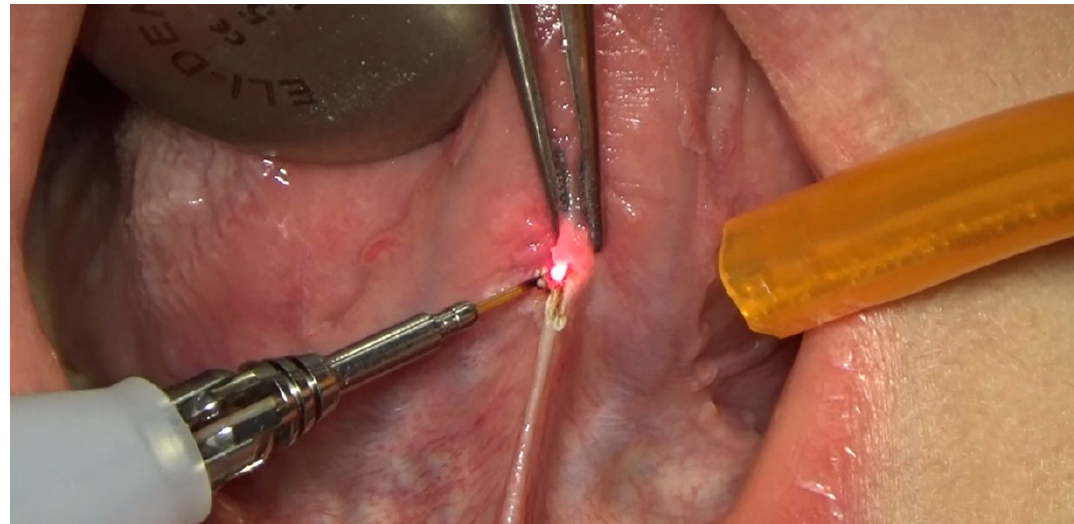
Figure 8. Surgery being performed.